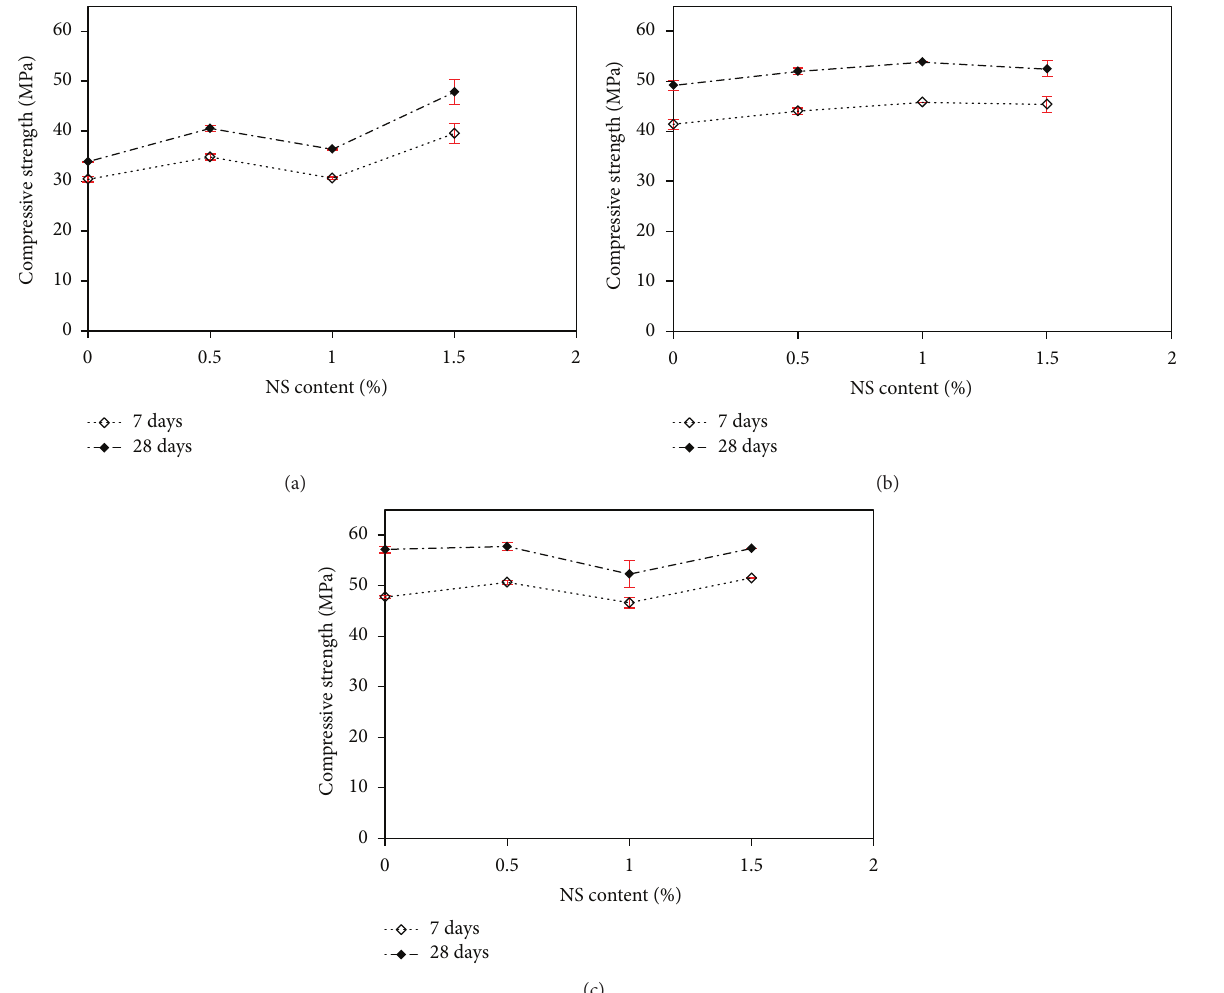
Figure 4: Compressive strength of concrete as a function of NS content (%) and curing time for w/b ratios: (a) 0.65, (b) 0.55, and (c)